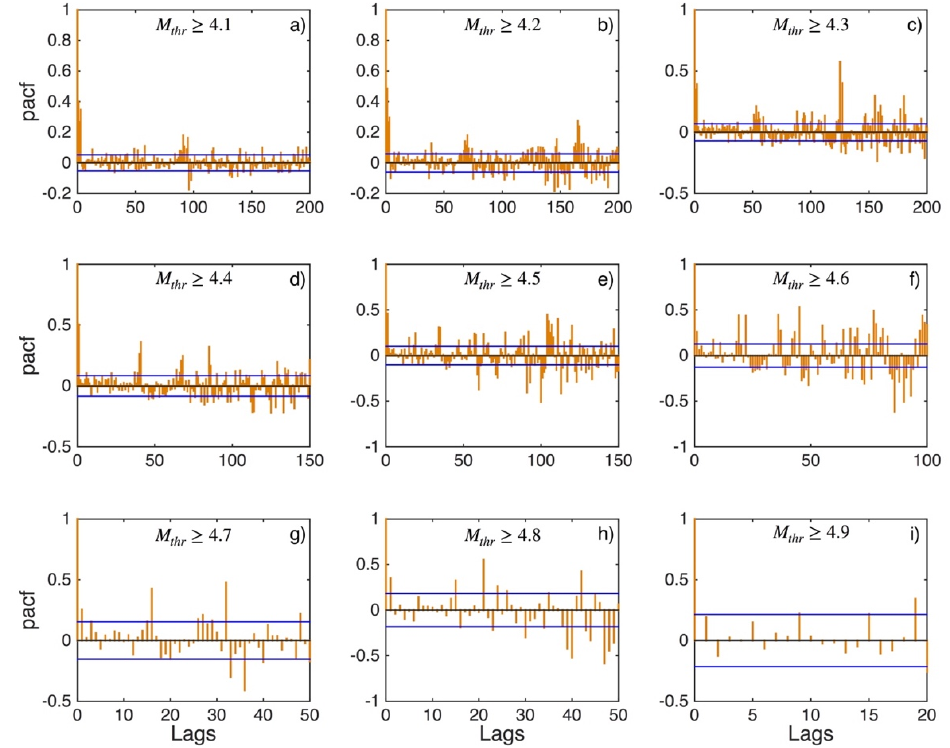
Figure 4. PACF values (orange stems) and their 95% confidence intervals (blue lines) for central Ionian Islands (sub − area 2) for magnitude thresholds ( M thr ) varying from 4.1 to 4.9 (subplots a – i ).